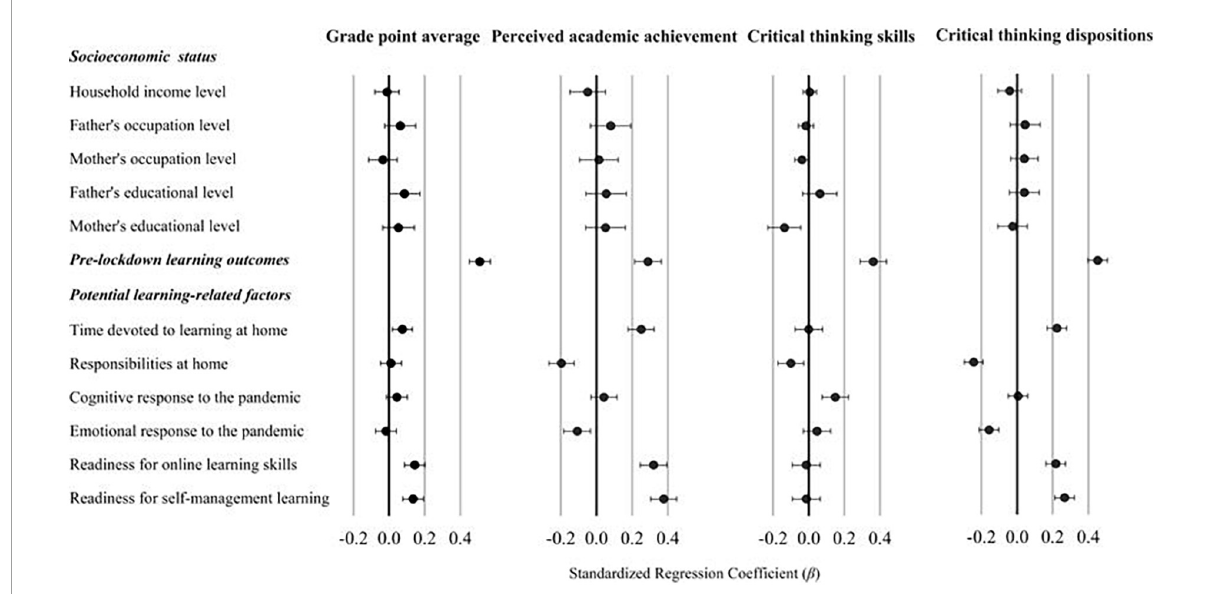
FIGURE3 Associations of socioeconomic status (SES) and pre-lockdown learning outcomes with post-lockdown outcomes. Separated hierarchical linear regressions were conducted with SES factors and pre-lockdown learning outcomes in the first step, and each learning-related factor in the second step (i.e., a separate model for each learning-related factor). Standardized regression coefficients ( β ) and 95% CIs were applied.